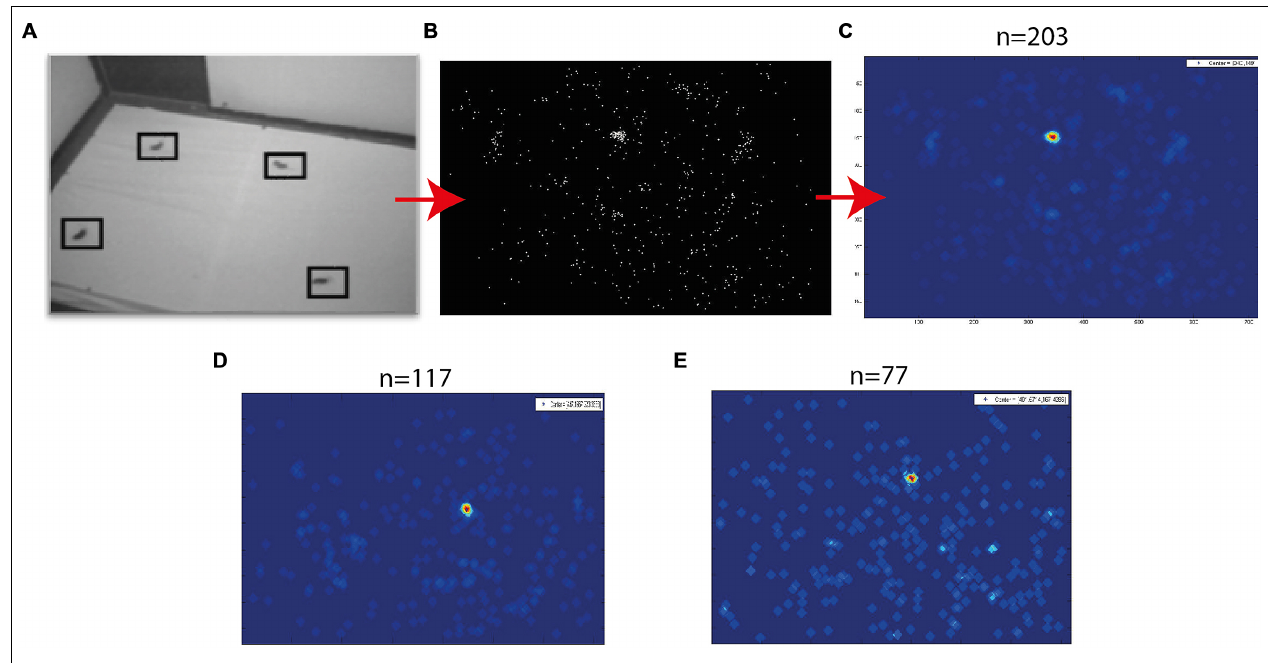
FIGURE 3 |Target probability maps. (A) An example of a single fixation frame. Four targets are marked by squares. (B) A plot showing all marked targets collected from a single experimental day. (C) The density function of the points in (B) . Red colors indicate high